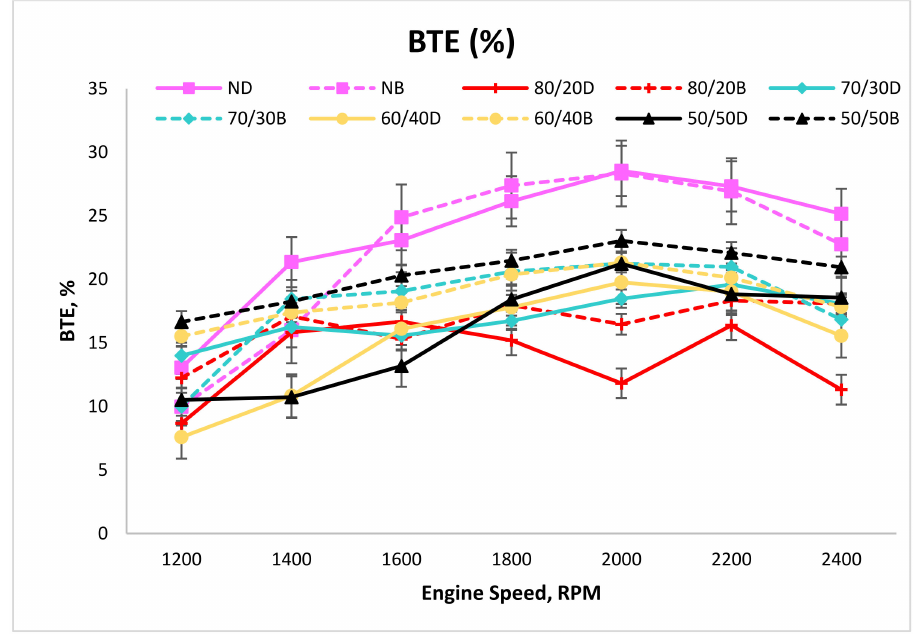
Figure 12. BTE percentage at various engine